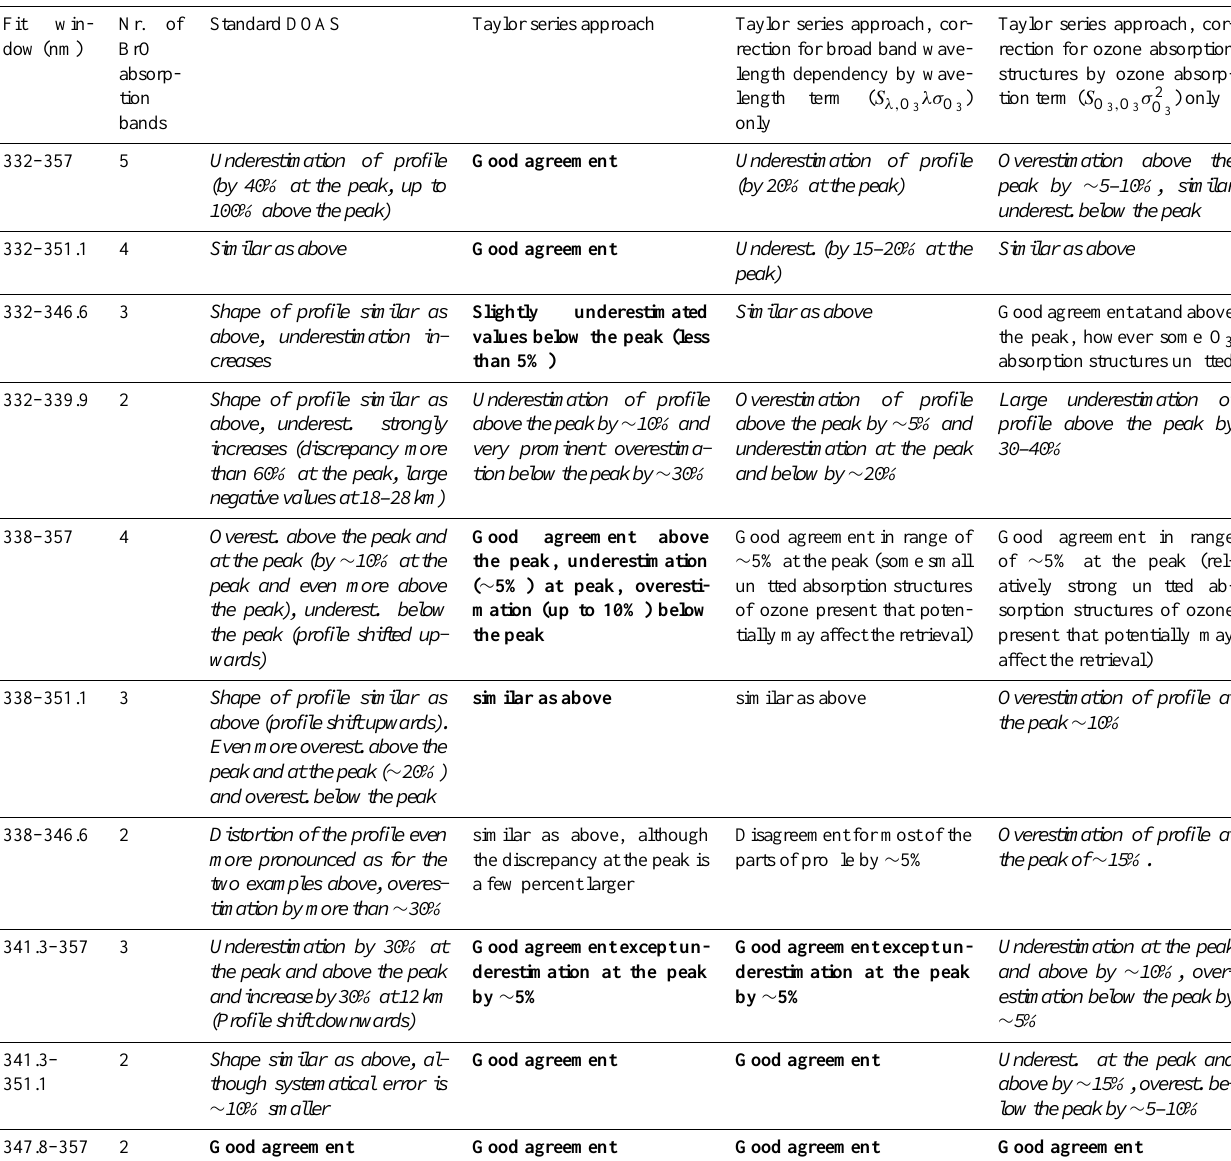
Table 5. Characterization of the BrO retrieval results obtained by different methods and applying different fit windows. Text in bold indicates good agreement, text in italic significant